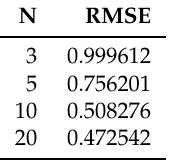
Table 2. RMSE of the calculated estimates using 100 samples with λ = 1 in Example